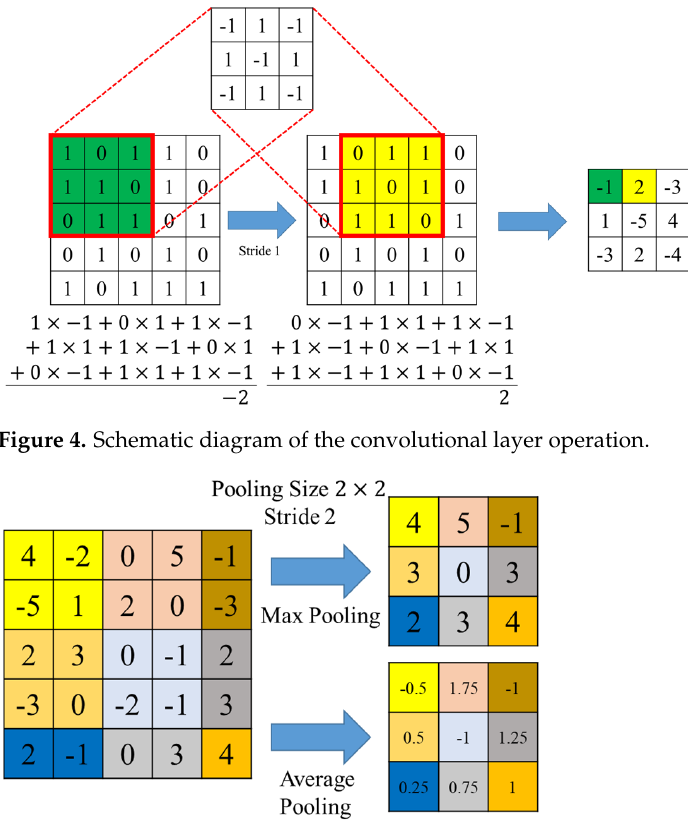
Figure 5. Schematic diagram of the pooling layer operation.